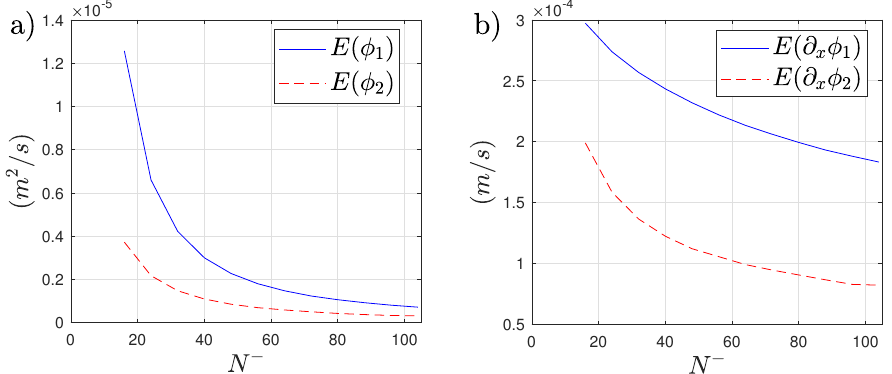
Figure 9. Numerical error of the multimodal matching as a function of the number of modes for the case α = 0.5. ( a ) Numerical error of the velocity potentials φ 1 and φ 2 . ( b ) Numerical error of the horizontal velocities ∂ x φ 1 and ∂ x φ 2